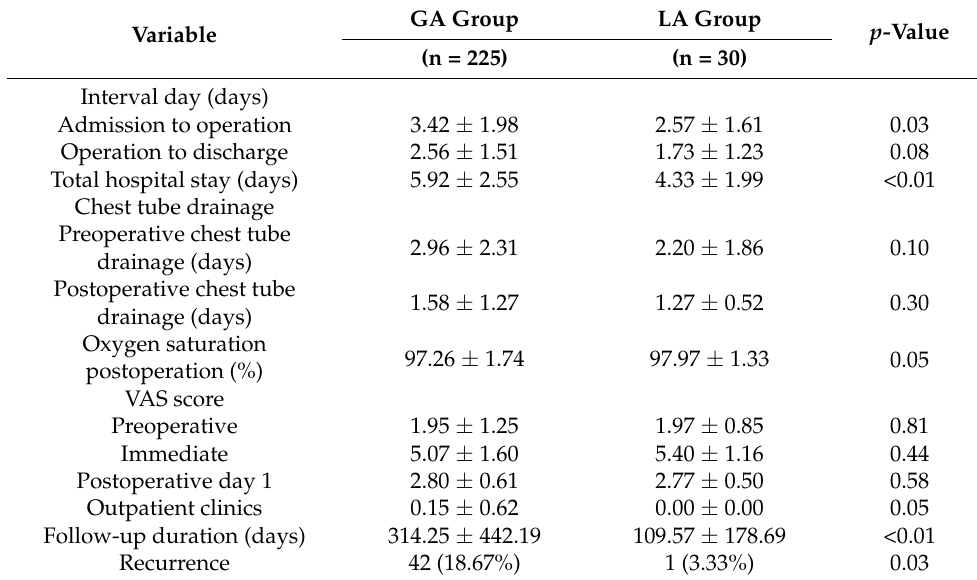
Table 3. Perioperative clinical